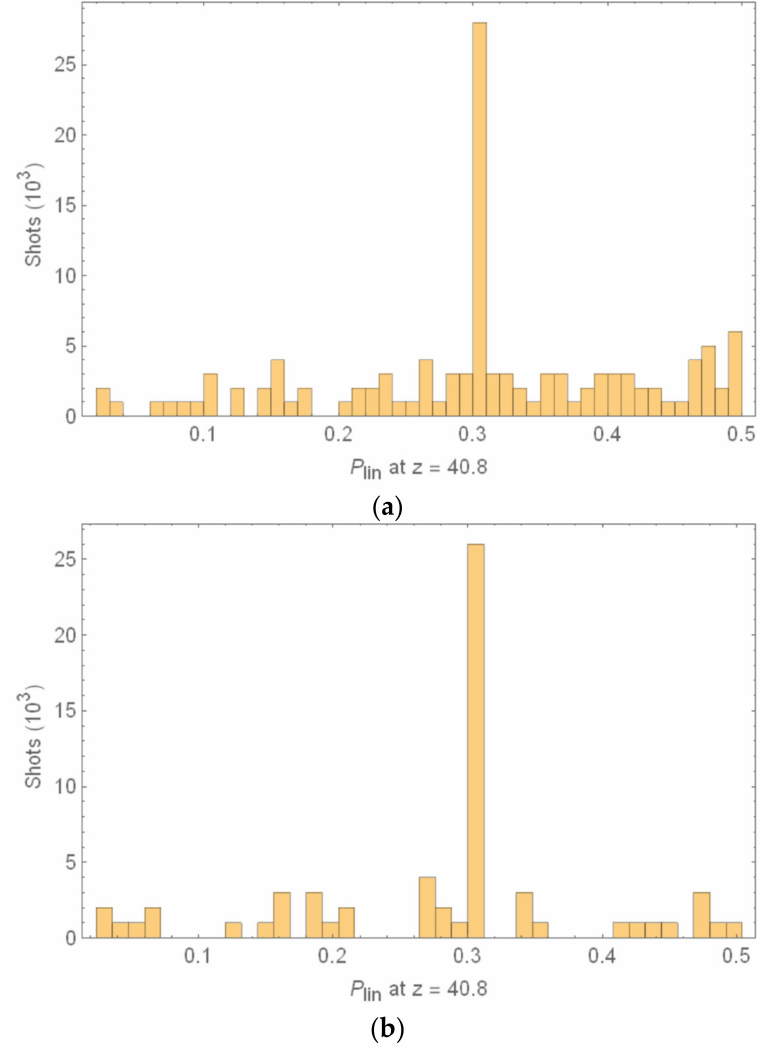
Figure 6. The distribution of the number of shots in the two-beam system ( a ) and in the single-beam system ( b ). The polarization states reached the degree of polarization over 90% at the center of the